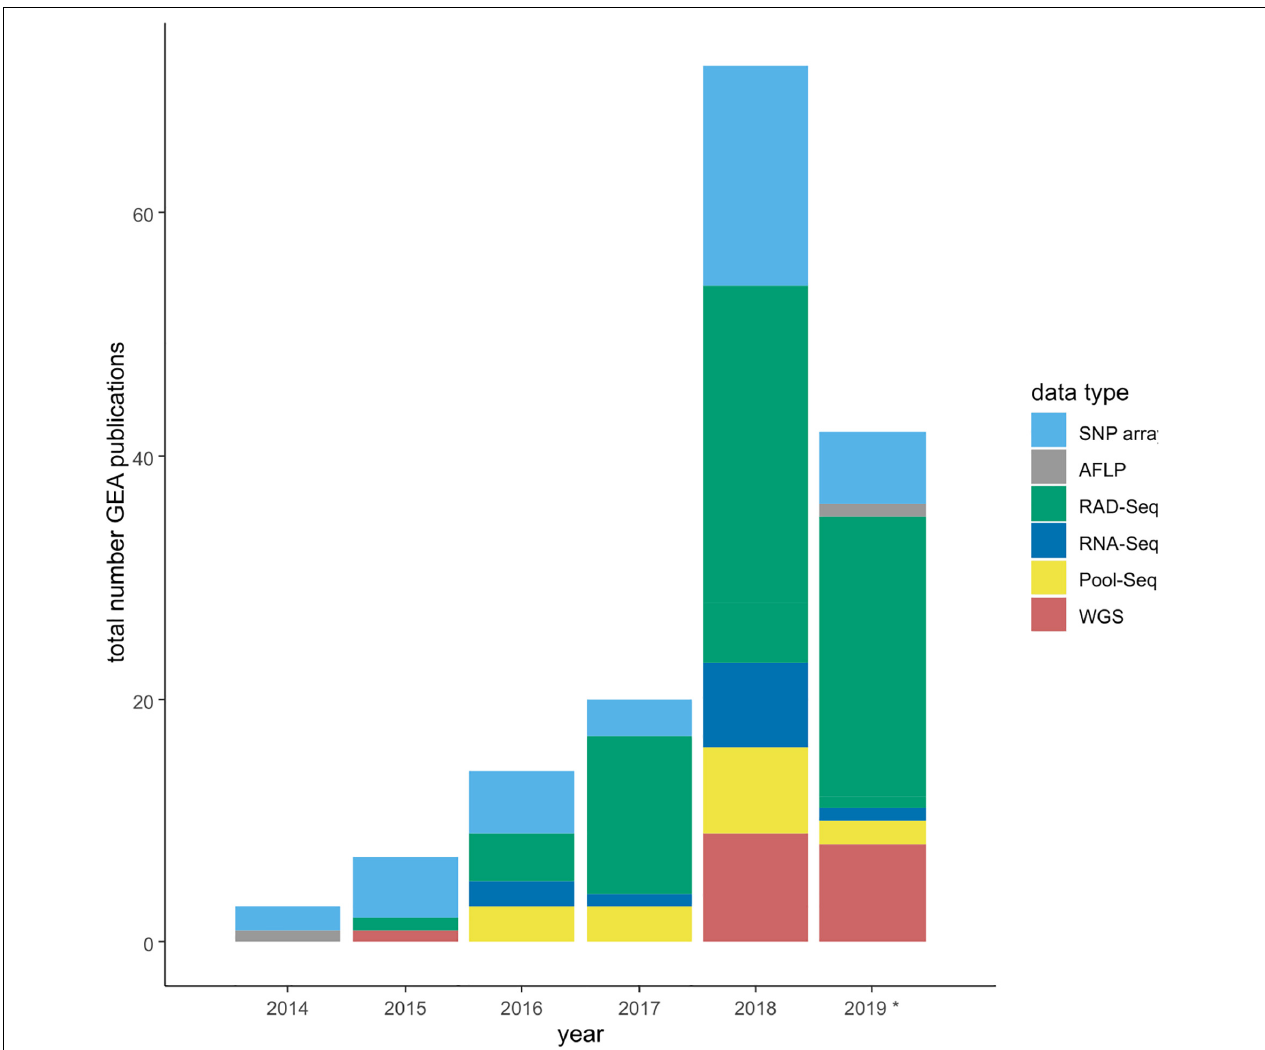
FIGURE 1 | Barplot depicting the increasing number of GEA studies per year, and the changes in the underlying sequence data types. SNP array data contain all studies making use of any type of SNP array, -panel and -chips. RAD-Seq summarizes studies using various types of GBS protocols. *Note: assessment until September 2019.